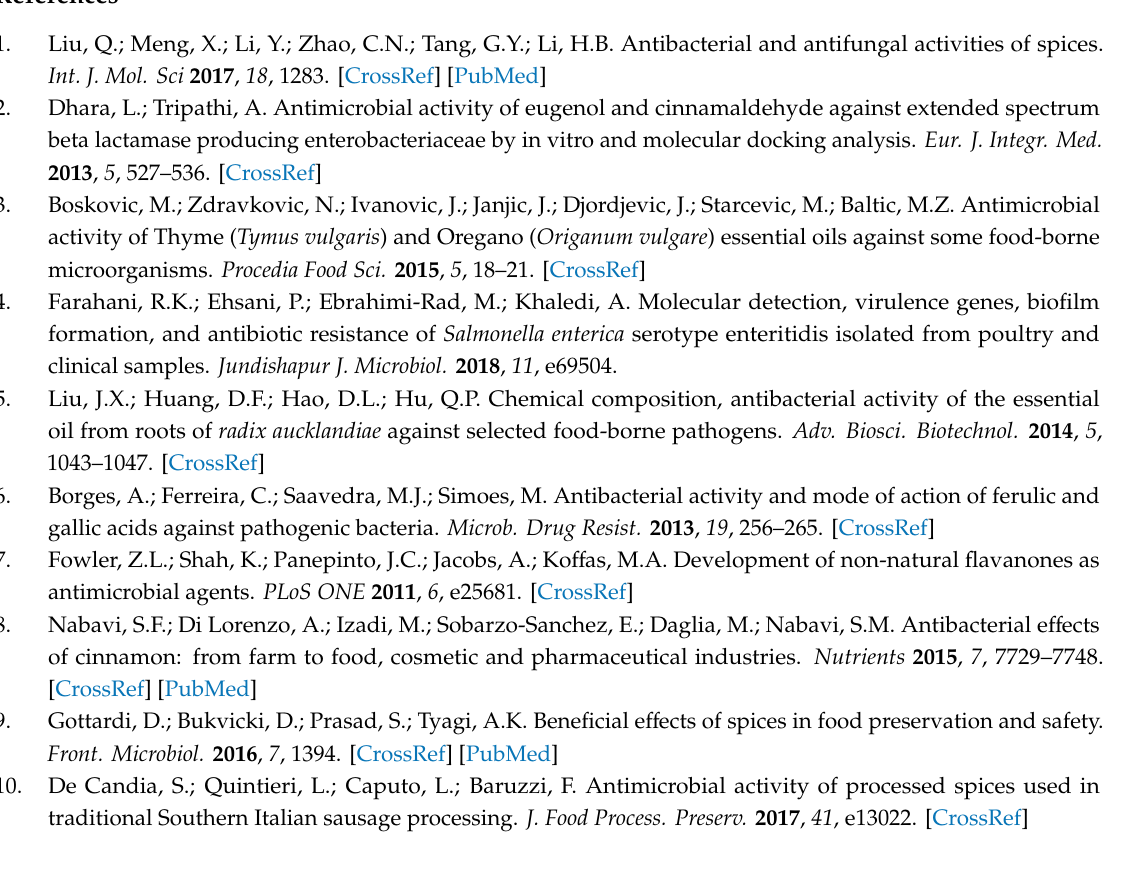
Table S1: The calculated general score of 67 extracts of